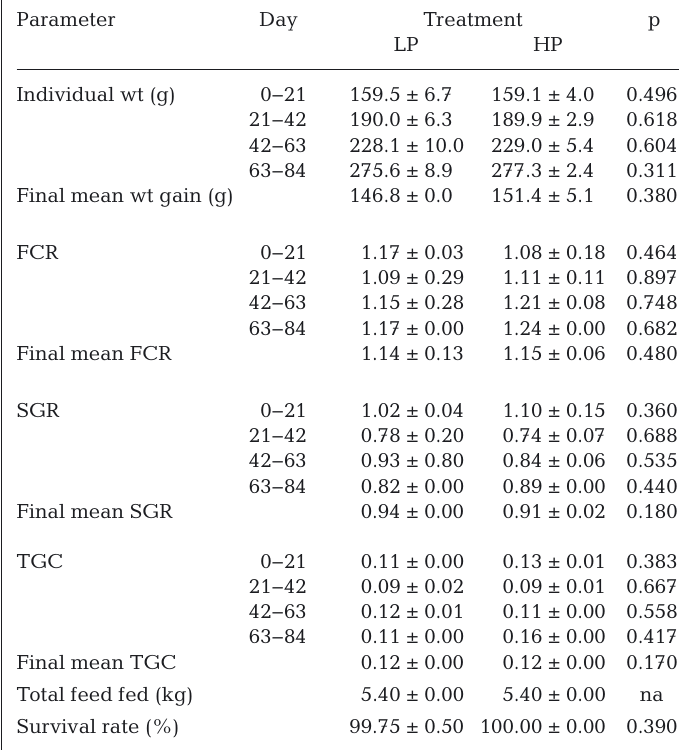
Table 2. Mean individual weight (wt) gain, feed conversion ratio (FCR) (see Eq. 2 in ‘Materials and methods’), specific growth rate (SGR) (see Eq. 3) and thermal-unit growth coefficient (TGC) (see Eq. 4) for rainbow trout Oncorhynchus mykiss fed low-phosphorus (LP) and